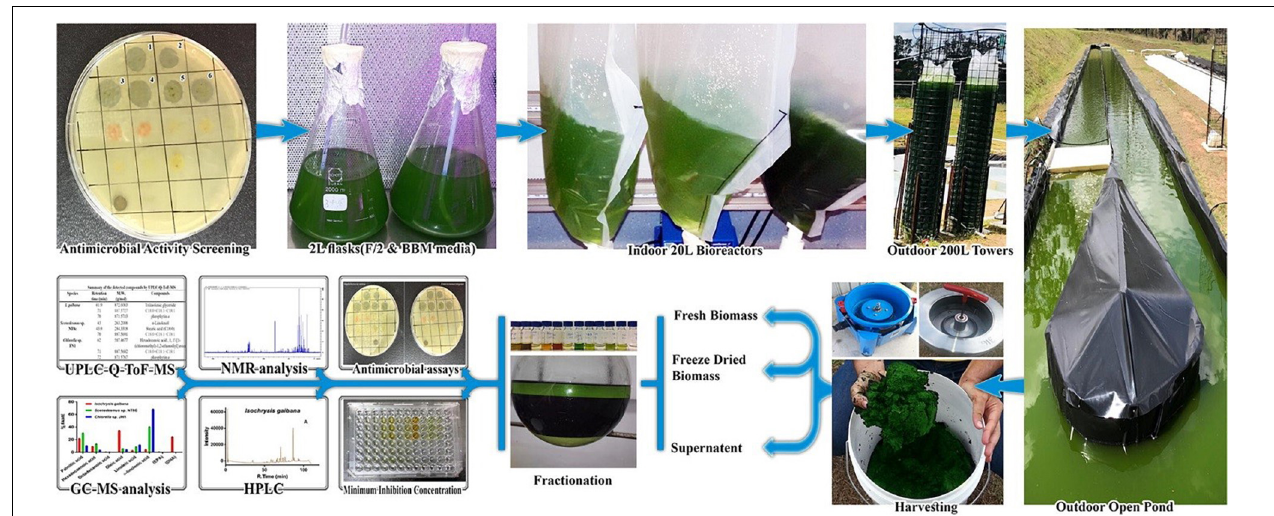
FIGURE 13 | Using chromatographic and mass spectroscopy combined methods for the evaluation of microalgae antimicrobial compounds (20) (Copyright permission: